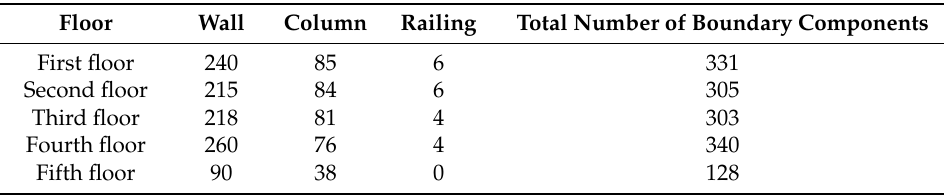
Table 2. Number of boundary components.